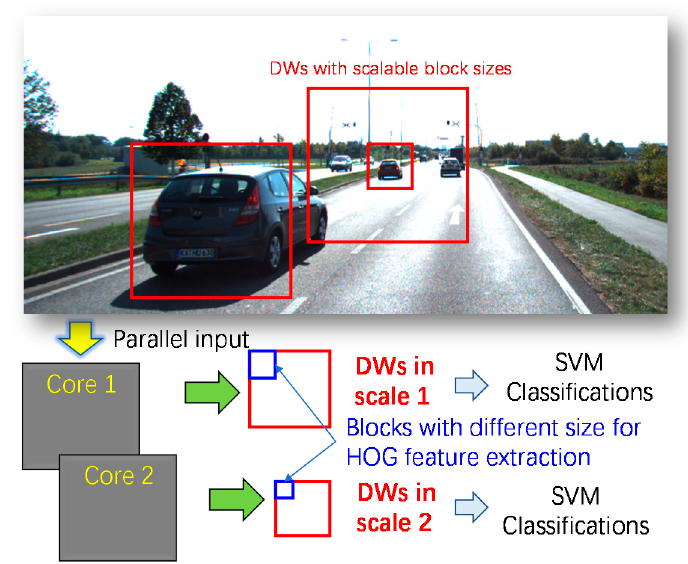
Figure 1. The overview of the proposed multi-core object detection coprocessor for multi-scale/type classification with the HOG and SVM framework.